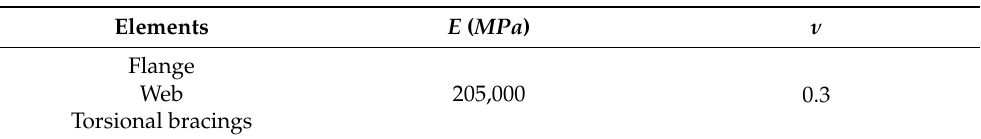
Table 2. Material properties used in FEA models.